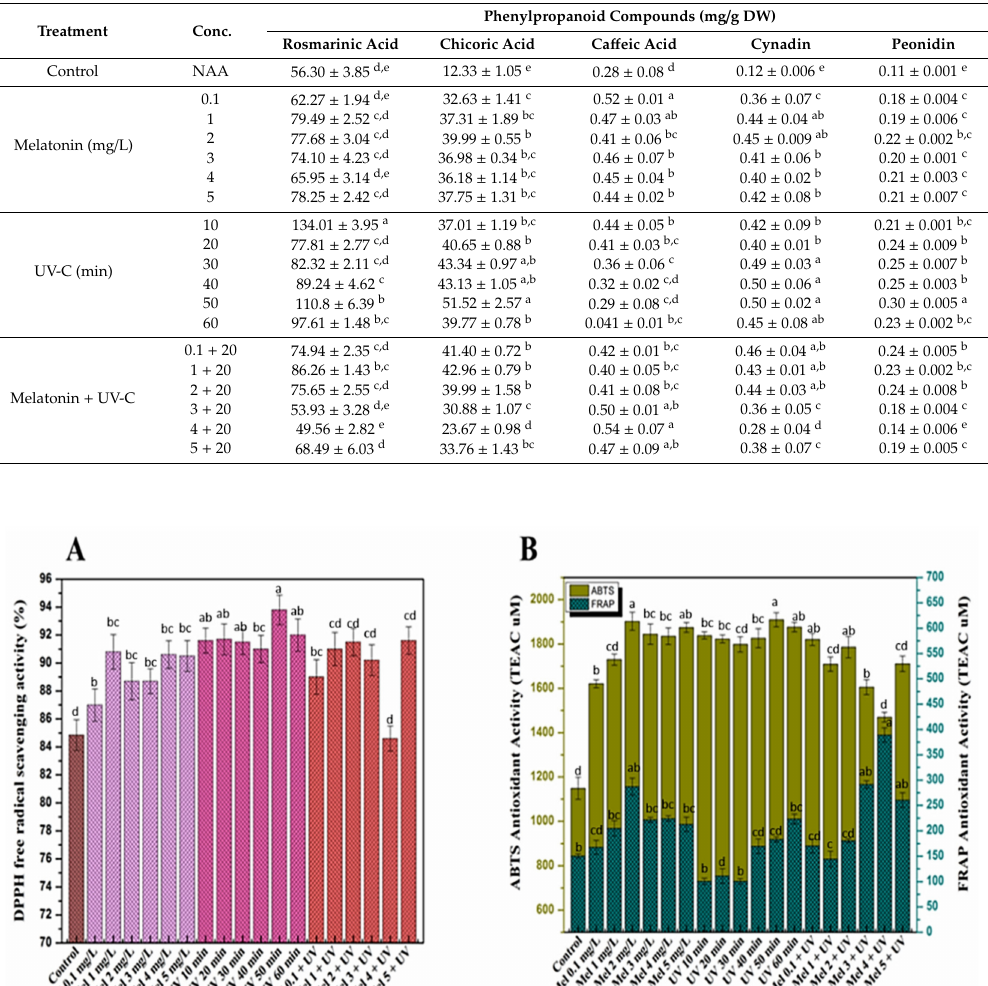
Table 1. E ff ects of melatonin, UV-C and Mel + UV-C on accumulation of phenylpropanoids in callus cultures of purple basil. Values are means of three independent replicates, and similar alphabets are not significantly di ff erent at p < 0.05.